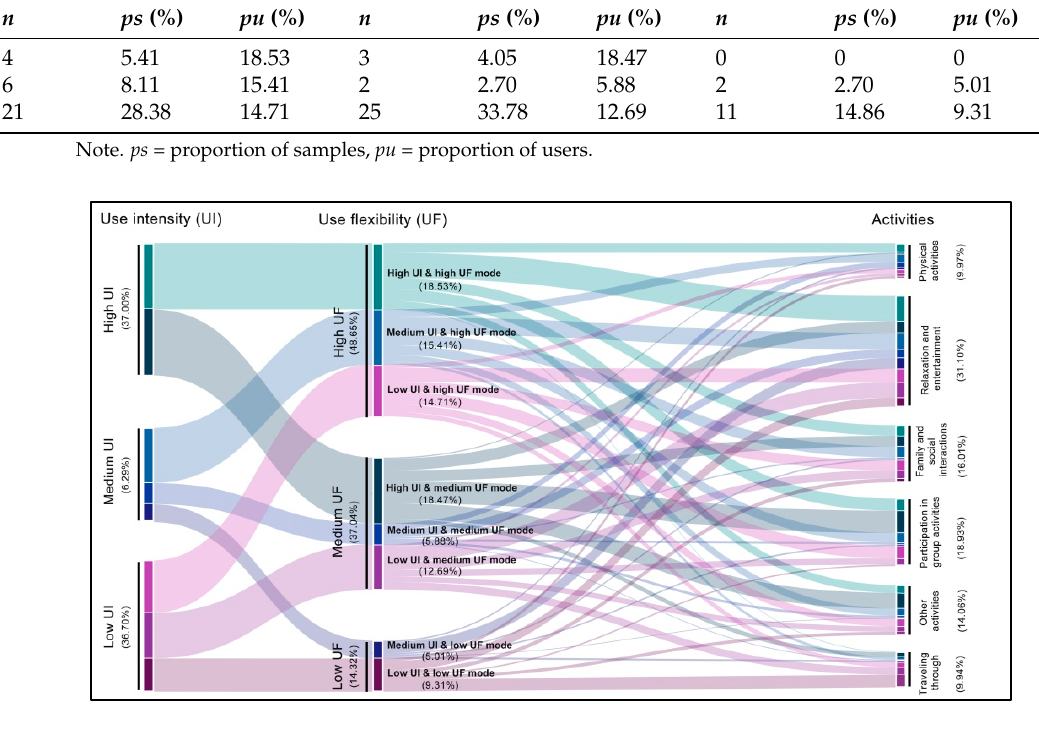
Figure 7. Distribution of park users in usage modes and activities.